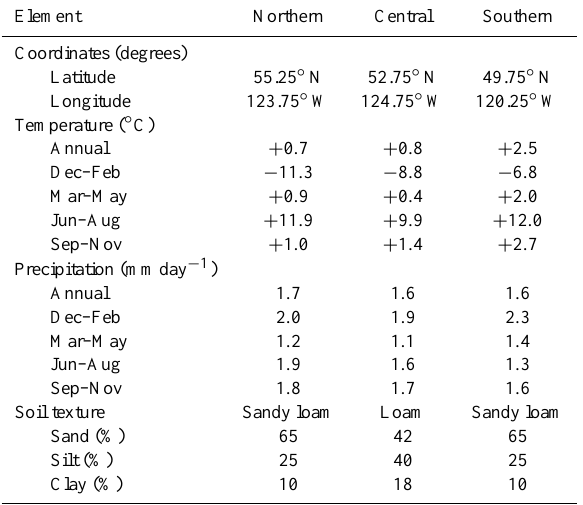
Table 3. Input climate data and soil texture for the three grid cells. Element Northern Central Southern Coordinates (degrees) Latitude 55.25 ◦